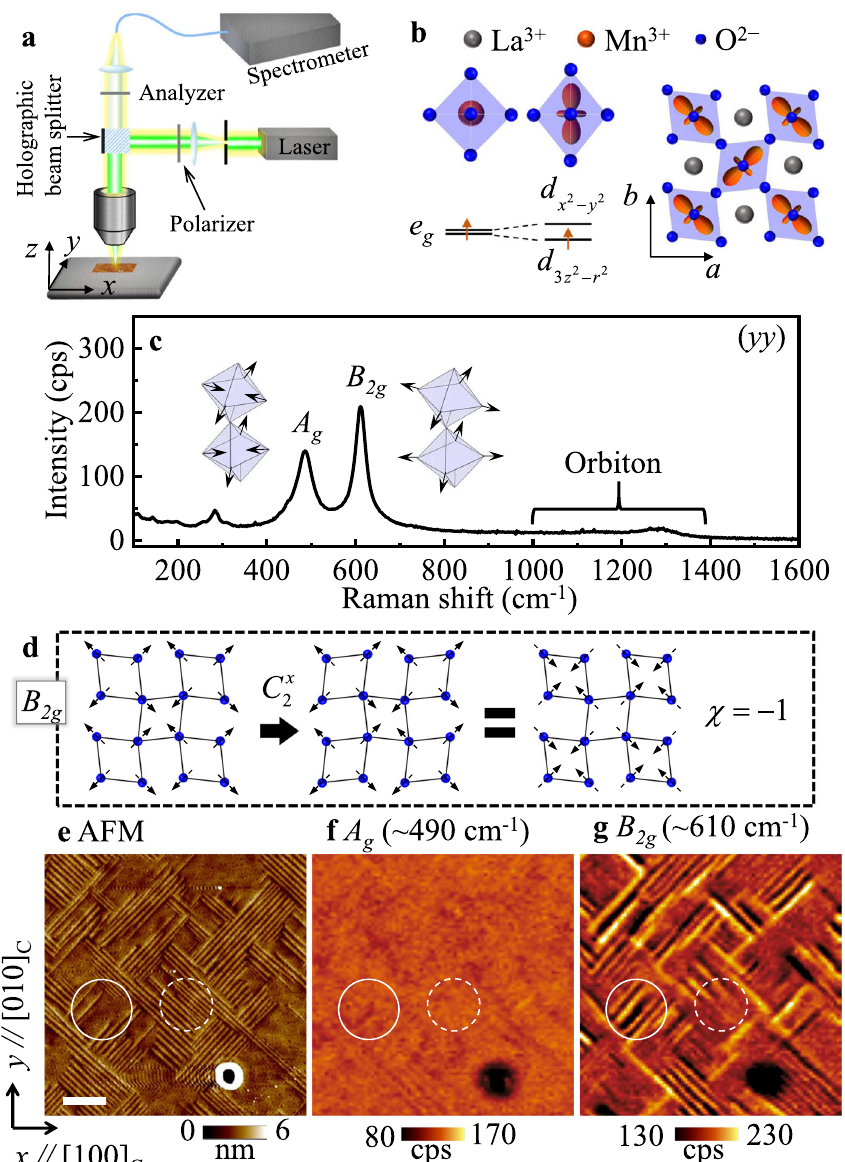
Fig. 1 Polarized Raman spectra and maps of a 150-nm-thick LMO thin fi lm. a Schematic of the experimental setup for the confocal Raman spectroscope with backscattering geometry. b Schematic diagrams of a JT distortion and the resultant energy shift of Mn e g levels, and the concomitant OO of singly occupied e g orbitals with the cooperative octahedral deformation within the ab plane. The ab JT planes are stacked along c axis and spaced from each other with a relatively smaller pseudocubic lattice parameter. c Raman spectrum measured in ( yy ) polarization geometry. In the inset, the anion vibrational patterns of two octahedra are depicted for A g and B 2g modes. d C x operation (two-fold rotation around a -axis) on the vibrating LMO cells under the B 2g symmetry results in the opposite phase of the vibration direction, denoted by the character ( χ ) of − 1. e AFM image. f Raman map of the A g mode at ~490 cm − 1 . g Raman map of the B 2g mode at ~610 cm − 1 . The areas marked in e-g with solid and dashed circles indicate the identical regions, respectively. The dark area in the lower right corner of the images is an intentionally burned area using a strong laser intensity. Scale bar indicates 2 μ